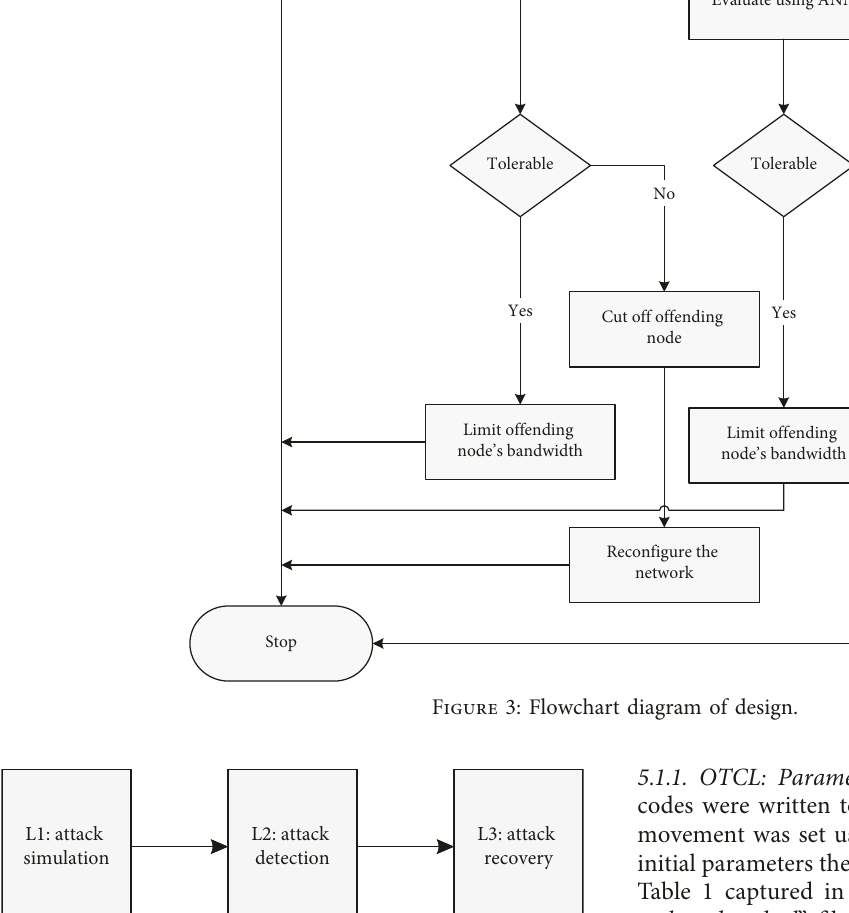
Figure 4: Final condensed flowchart design for